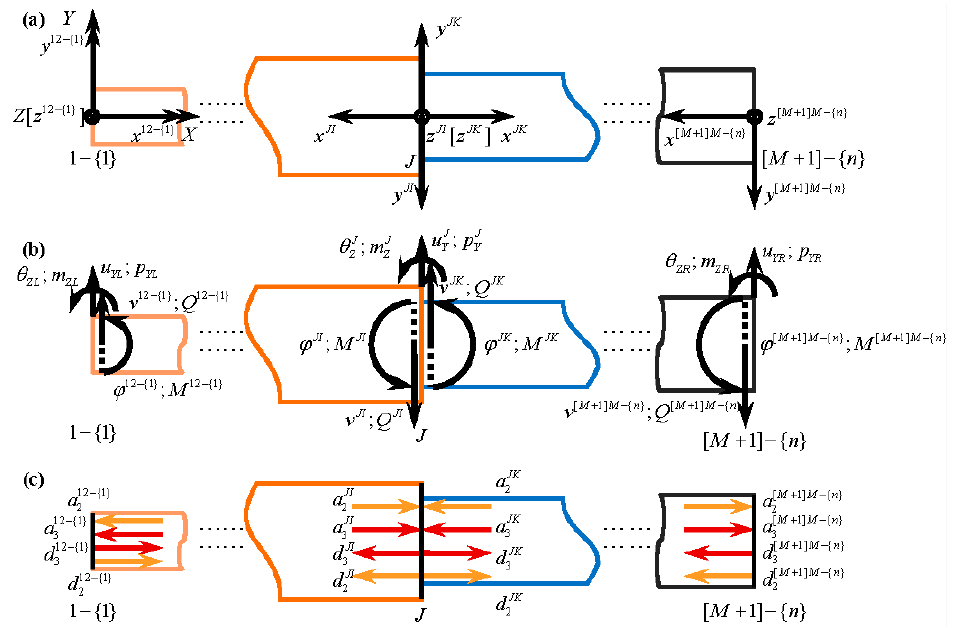
Figure 4. The description of the left exterior joint 1 − { 1 } , a typical interior joint J and the right exterior joint [ M + 1 ] − { n } : ( a ) The global coordinates and the dual local coordinates of the relative members; ( b ) The generalized displacements and forces of these joints and of their relative members; ( c ) The wave amplitudes of the relative members.